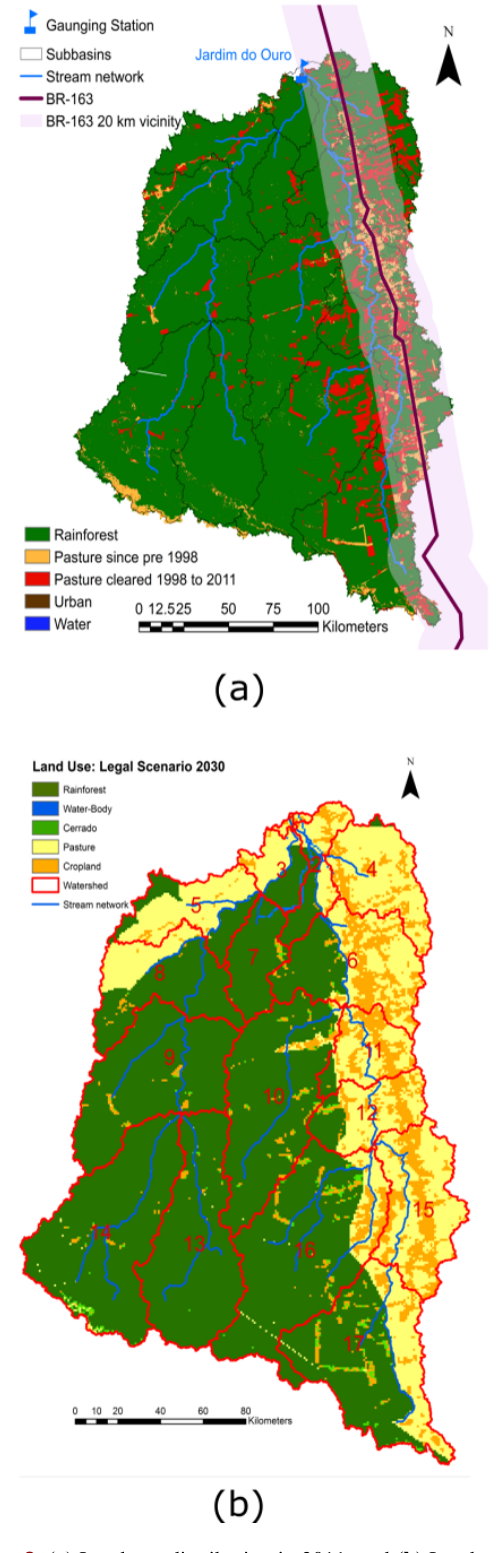
Figure 2. (a) Land-use distribution in 2011, and (b) Land-use sce- nario (22% of deforestation) for the year 2030 following a business as usual approach (Gollow et al., 2017).